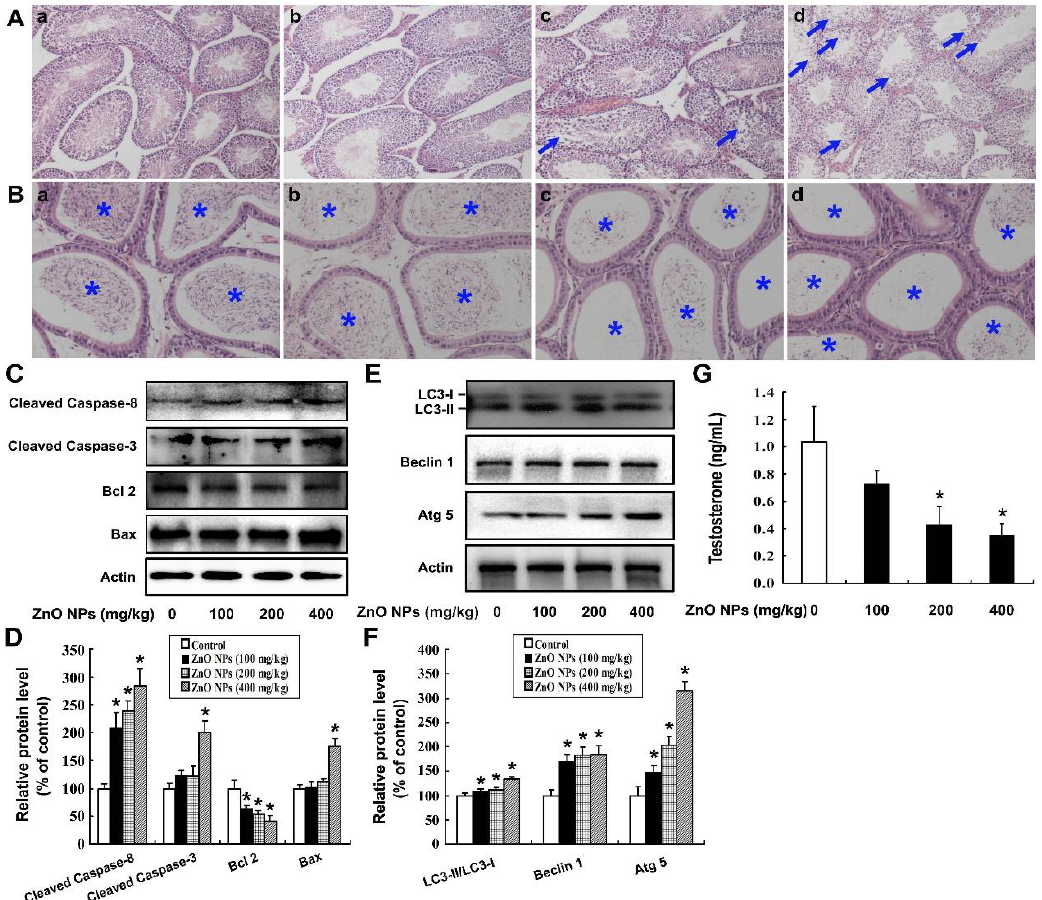
Figure 1. Intragastrical exposure of zinc oxide nanoparticles (ZnO NPs) cause toxic damage to the mouse male reproductive system. ( A ) Testes were obtained from male mice treated with 0 ( a ), 100 ( b ), 200 ( c ), or 400 ( d ) mg ZnO NPs / kg / day for 28 days. The testes were stained with hematoxylin and eosin (HE) and then were visualized under an IX51 Olympus microscope. The disruption of the seminiferous epithelium in the testis is indicated by arrows. Magnification: 100 × . ( B ) Epididymides were obtained from male mice treated with 0 ( a ), 100 ( b ), 200 ( c ), or 400 ( d ) mg ZnO NPs / kg / day for 28 days, and stained with HE. The sperm in the epididymis are indicated by an asterisk. Magnification: 200 × . ( C ) The protein levels of cleaved Caspase-3, cleaved Caspase-8, Bax, and Bcl 2 and ( E ) the levels of LC3, Beclin 1, and Atg 5 were detected by Western blot; Actin was used as an internal control. ( D,F ) The relative protein levels were quantified by densitometry. ( G ) The serum testosterone concentration. The experiment was done in triplicate and repeated three times ( n = 9). Data were analyzed by one-way ANOVA. * p <